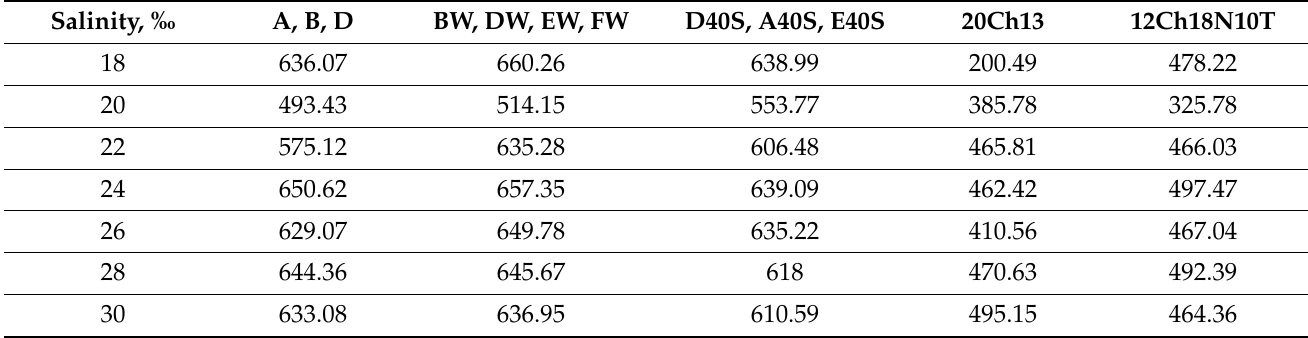
Table 2. Corrosion potential of shipbuilding steels with an oxide film.